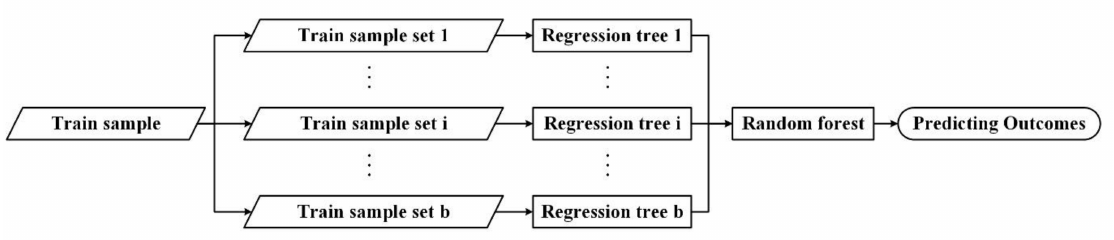
Figure 6. Random forest regression